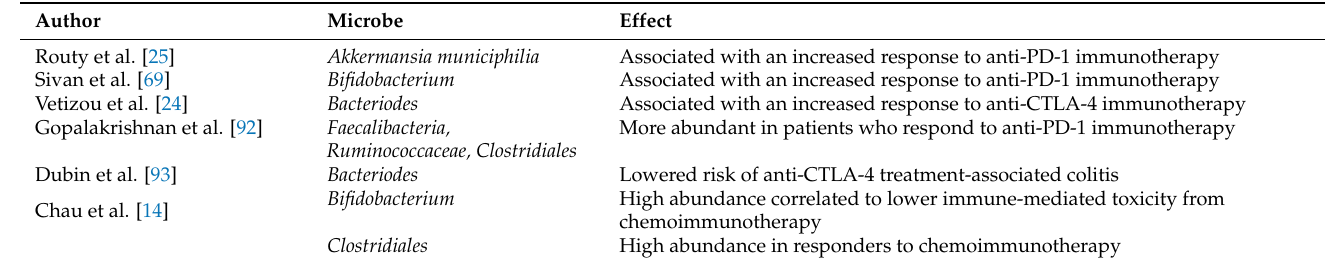
Table 2. The effects of gut microbiota on immunotherapy